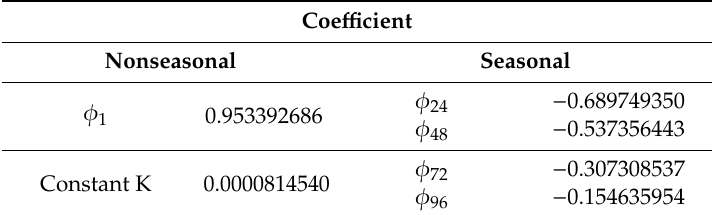
Table3. SeasonalAutoregressiveIntegratedMovingAveragemodel(SARIMA)coefficients. Electricityprice. Table 3. Seasonal Autoregressive Integrated Moving Average model (SARIMA) coefficients. Electricity